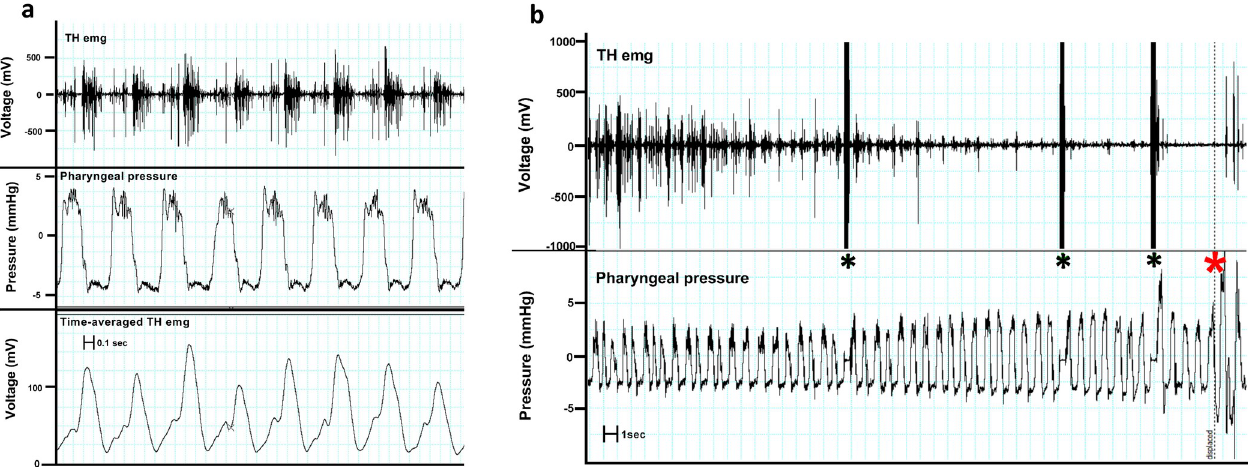
Fig 2. Electromyographic activity of the thyro-hyoid (TH) muscle in an exercising horse. TH electrical activity (TH emg) is synchronous with inspiration (2a), increases with swallowing and is absent immediately prior to dorsal displacement of the soft palate (DDSP) (2b). 2b) Representative raw electromyographic activity of the thyro-hyoid muscle and pharyngeal pressure in a horse affected with intermittent DDSP. Black asterisks indicate swallows; the red asterisk indicates the DDSP episode. Note the marked reduction in the breathing related EMG activity prior to development of DDSP. The Y-axis is limited to +/-1000mV to facilitate viewing of EMG trace.